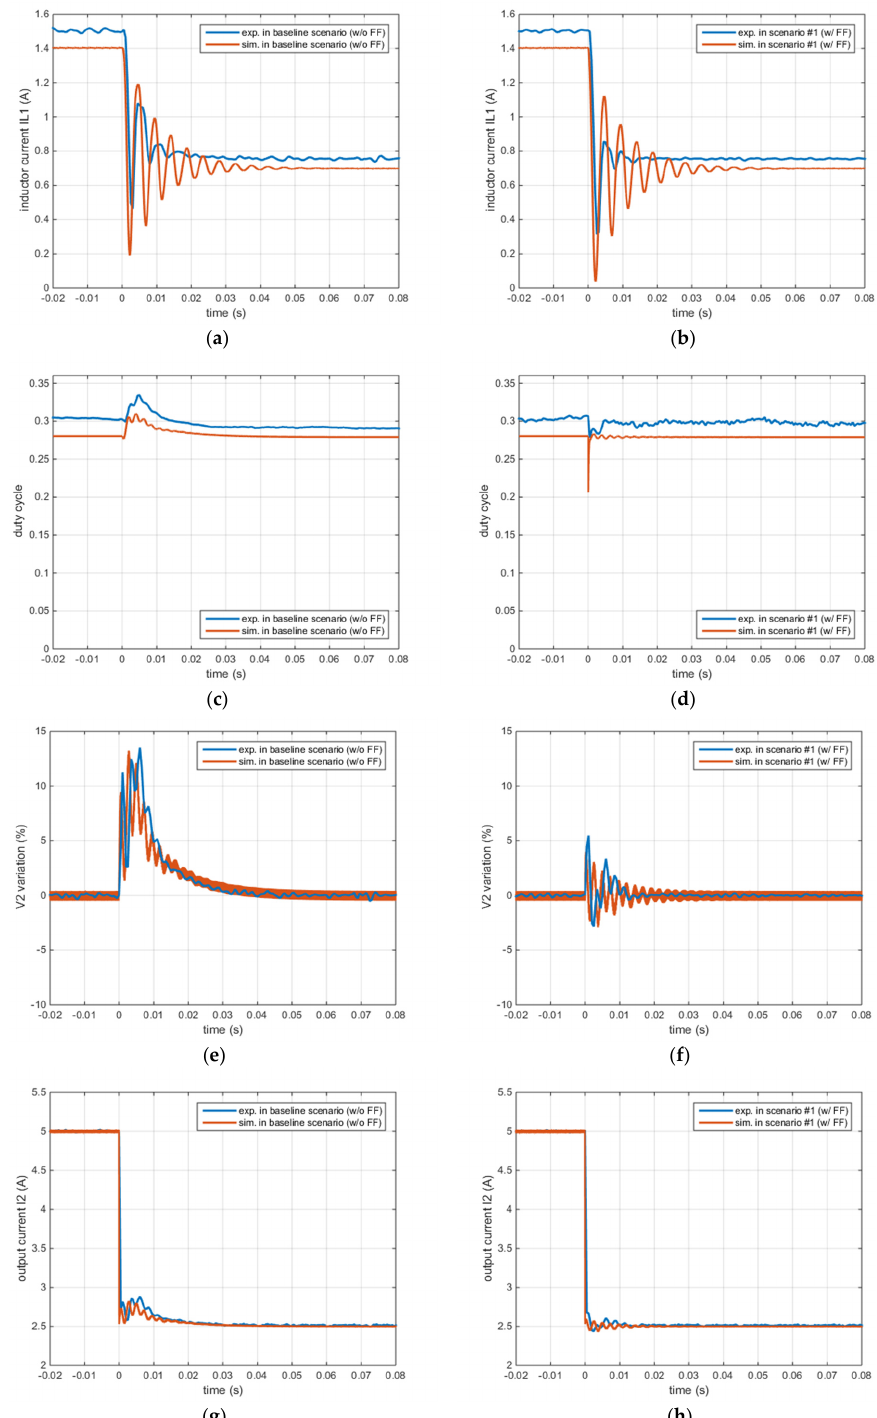
Figure 10. Comparison between simulation and experimental results in the baseline scenario (left) and Scenario #1 (SS − GN) (right): ( a , b ) input inductor current; ( c , d ) duty cycle; ( e , f ) grid voltage variation; ( g , h ) output current.